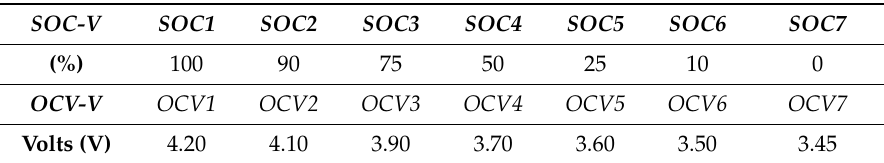
Table 1. The reference SOC-OCV calibration values.